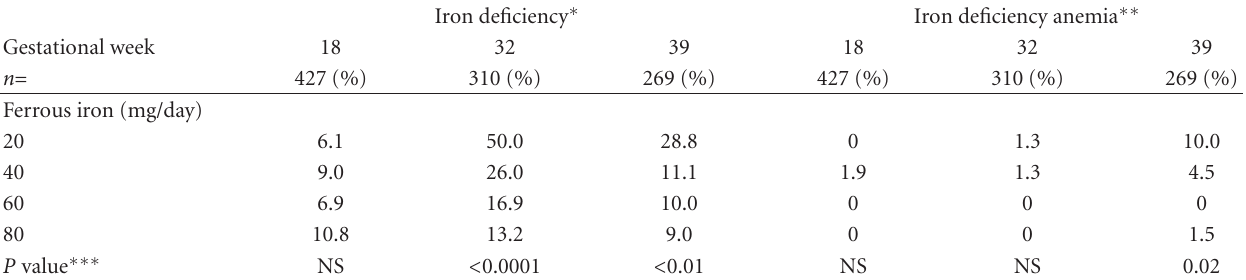
Table 2: Prevalence of iron deficiency and iron deficiency anemia during pregnancy in Danish women according to ferrous fumarate iron supplements taken between meals from 18 weeks gestation to delivery